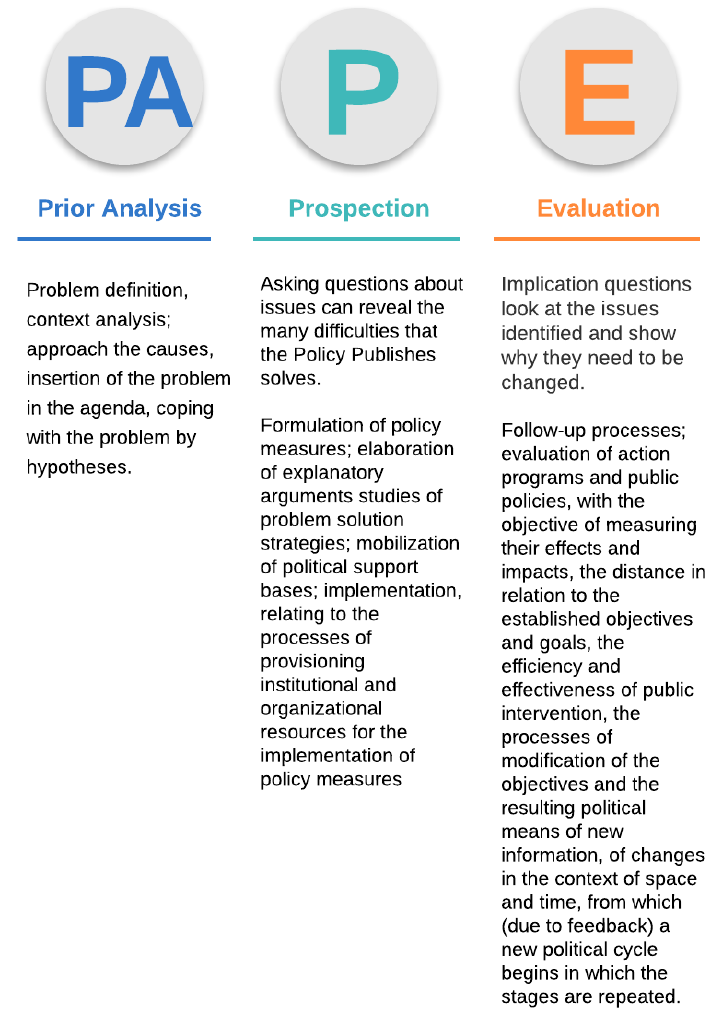
Figure 4. Pre-Analysis, prospecting, and evaluation Stages.